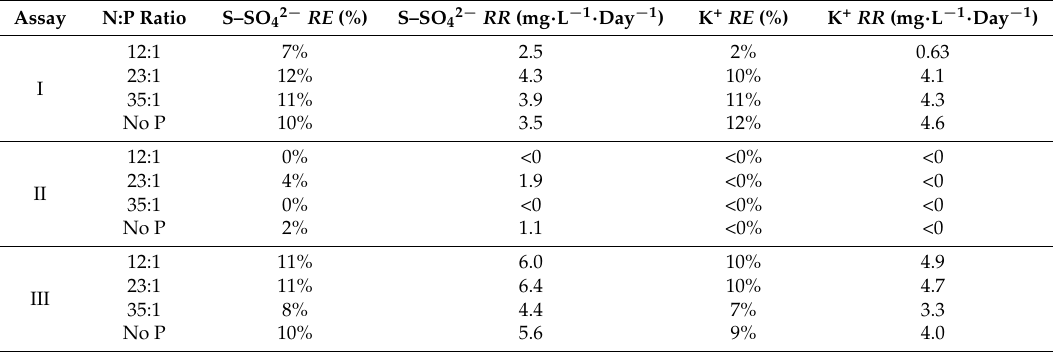
Table 3. SO 42 − and K + ion removal parameters determined for assays I, II and III under different N:P